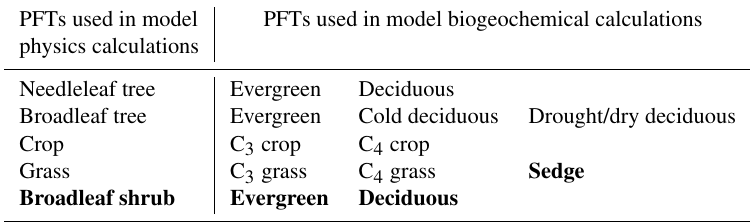
Table 1. Mapping between plant functional types (PFTs) used in CLASSIC’s physics and biogeochemical calculations. PFTs in bold font indicate the new PFTs incorporated by our study. PFTs used in model physics calculations Needleleaf tree Evergreen